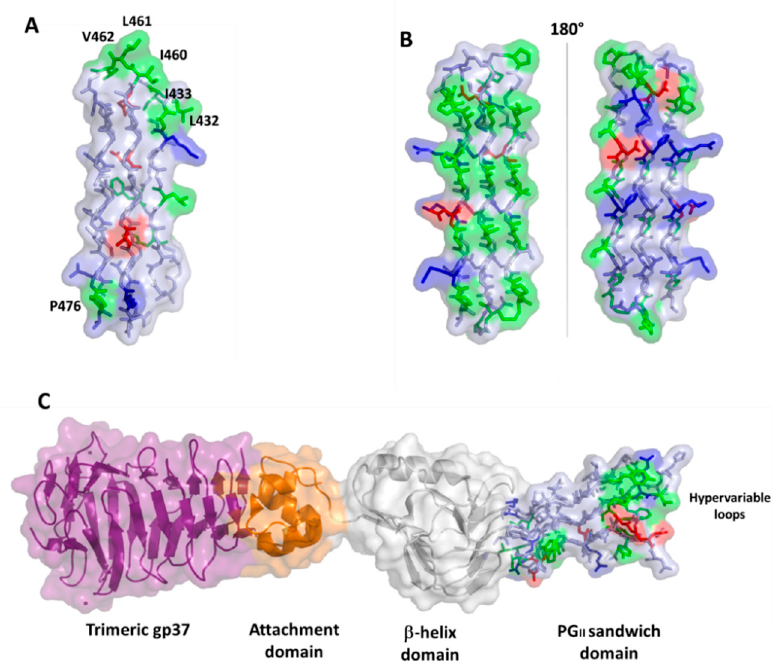
Figure 6. Surface and stick representations of PG II domains in ( A ) PE_PGRS33 (domain PG II 4); ( B ) antifreeze protein sfAFP (pdb code 2pne) in two 180° views; and ( C ) Salmonella bacteriophage S16 long tail fiber (pdb code 6F45). In this panel, the PG II domain is located at the C-terminal side of the protein (stick and surface representation). Adjacent domains are drawn in surface and cartoon representations. In all panels, the color code used for PG II residues is red for negative, blue for positive, green for hydrophobic, and light blue for polar residues.